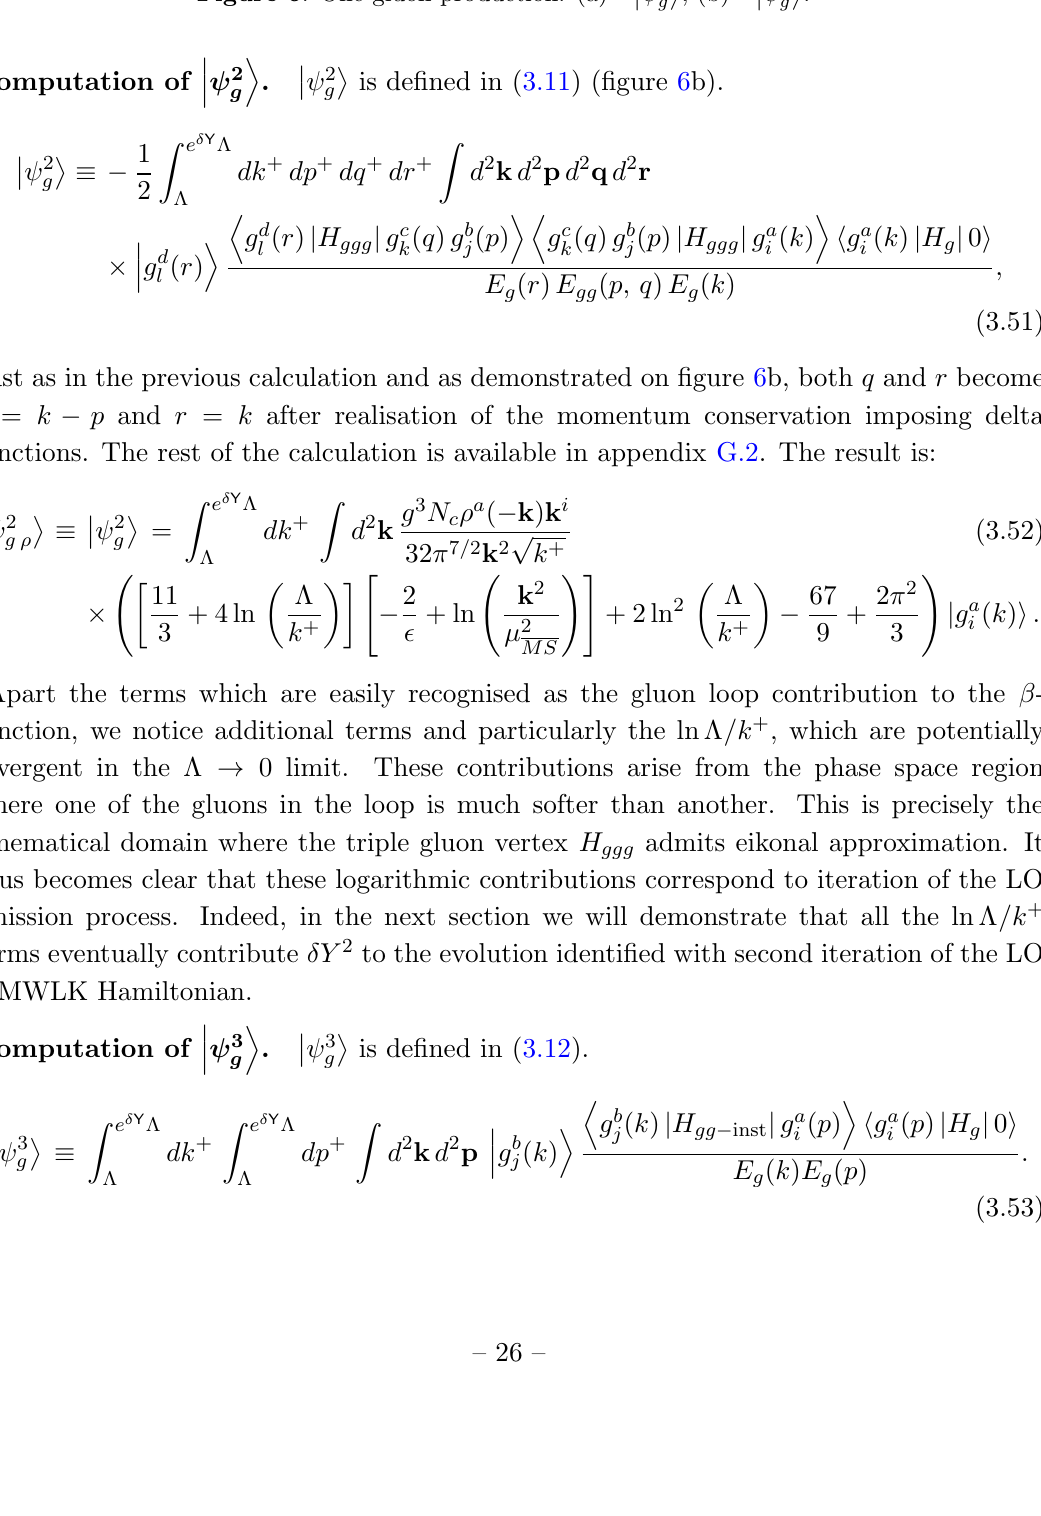
Figure 6 . One gluon production. (a) -